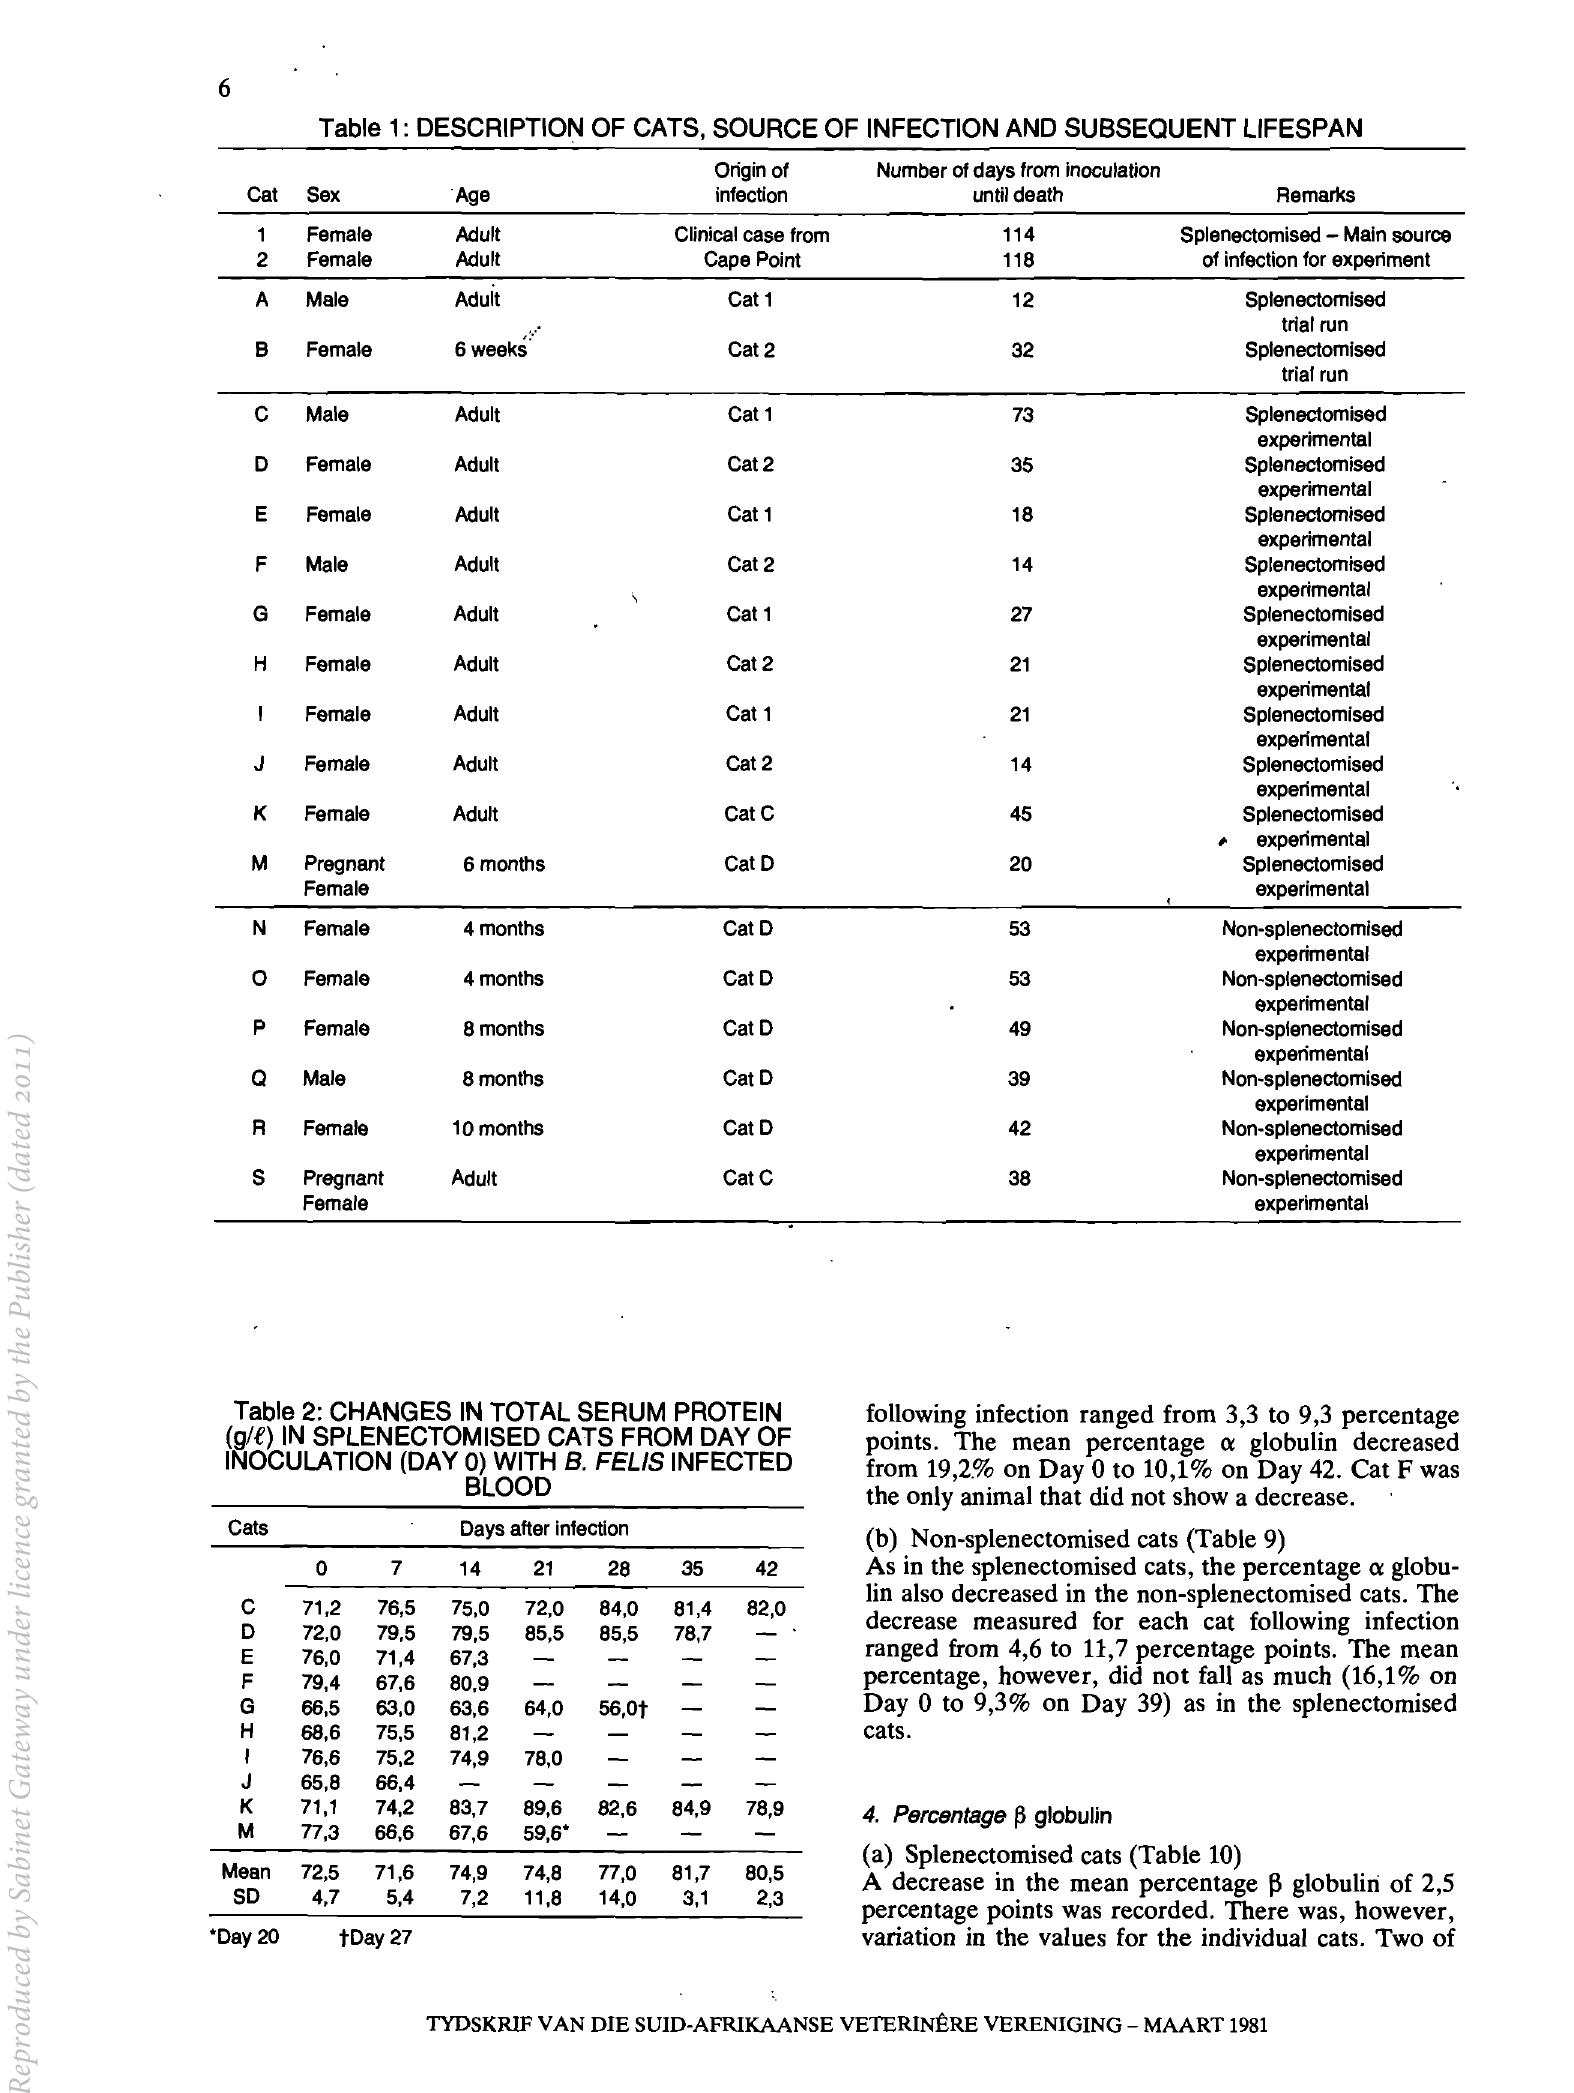
Table 2: CHANGES IN TOTAL SERUM PROTEIN following infection ranged from 3,3 to 9,3 percentage (9/£) IN SPLENECTOMISED CATS FROM DAY OF points. The mean percentage a: globulin decreased INOCULATION (DAY 0) WITH B. FELIS INFECTED from 19,2% on Day 0 to 10,1% on Day 42. Cat F was BLOOD the only animal that did not show a